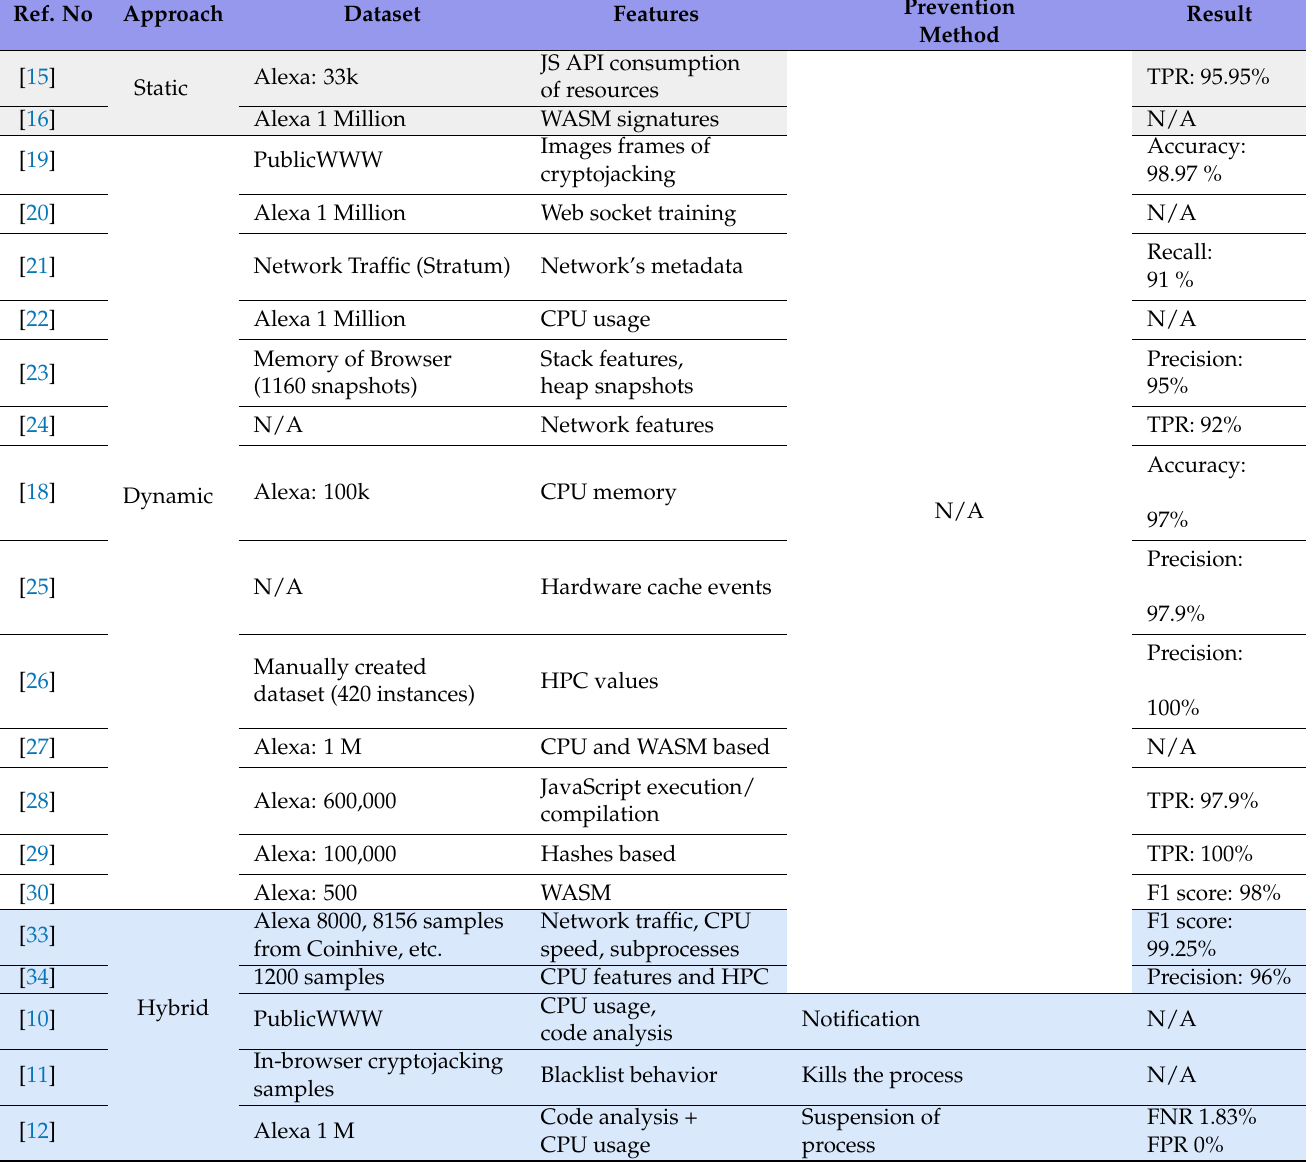
Table 1. Summary of the state of the art on in-browser cryptojacking